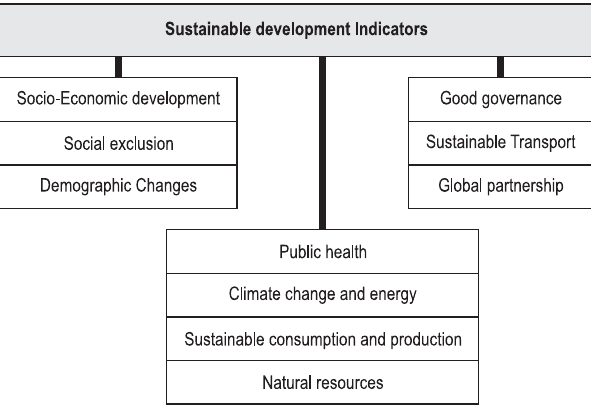
Fig. 2. Classifi cation of Sustainable development indicators (Monitoring report of the EU Sustainable development strategy 2007)